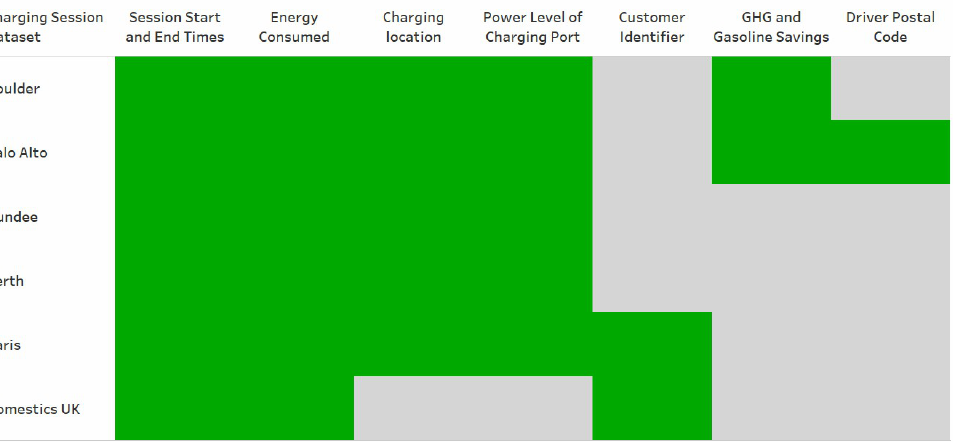
Figure 3. Fields available (in green) and missing (in grey) in the six datasets